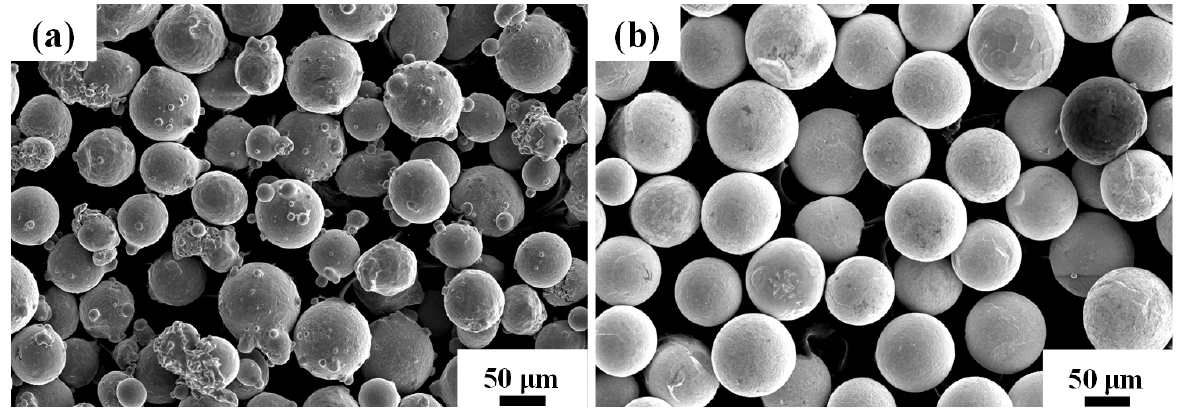
Figure 1. SEM images of powders. ( a ) Spherical IN718; ( b ) spherical WC.